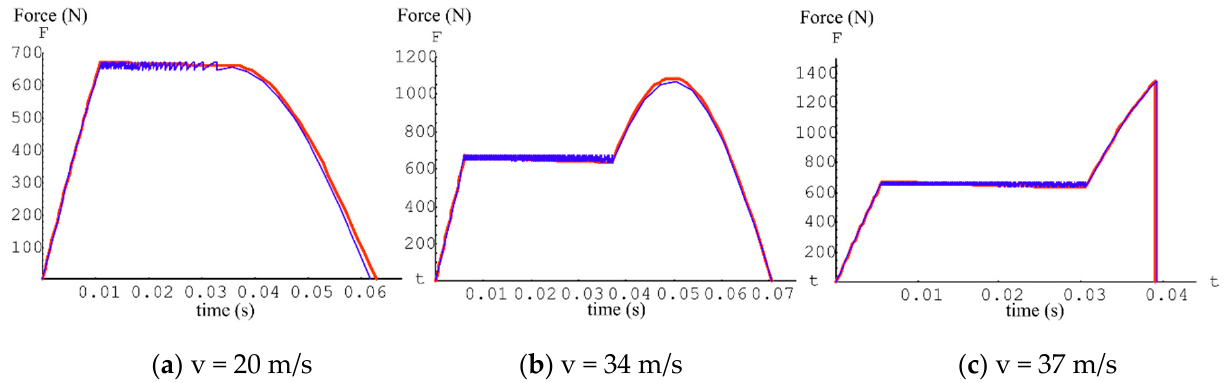
Figure 8. Elongations at various initial velocities (v = 7 m/s, 13 m/s, 14 m/s). Number of segments = 15, red line: approximate solution, blue line: exact solution.